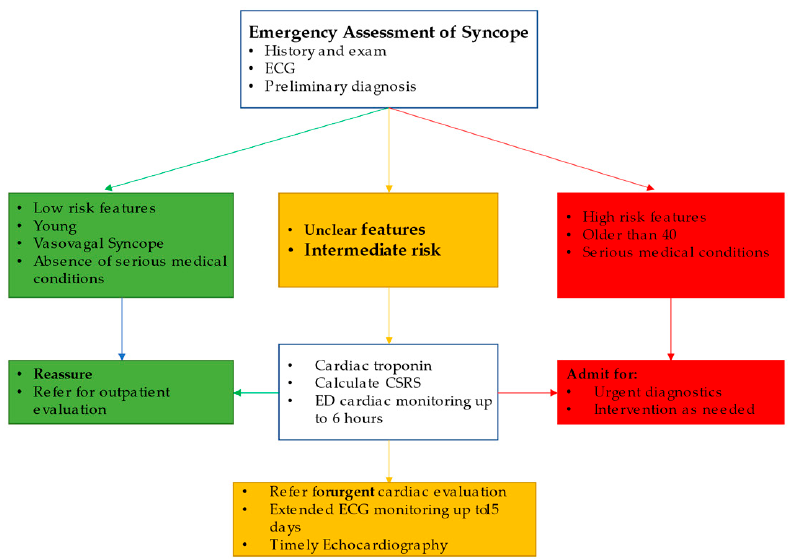
Figure 3. The authors recommended approach to syncope patients in the ED based on history and physical exam, ECG, ED diagnosis, and CSRS.